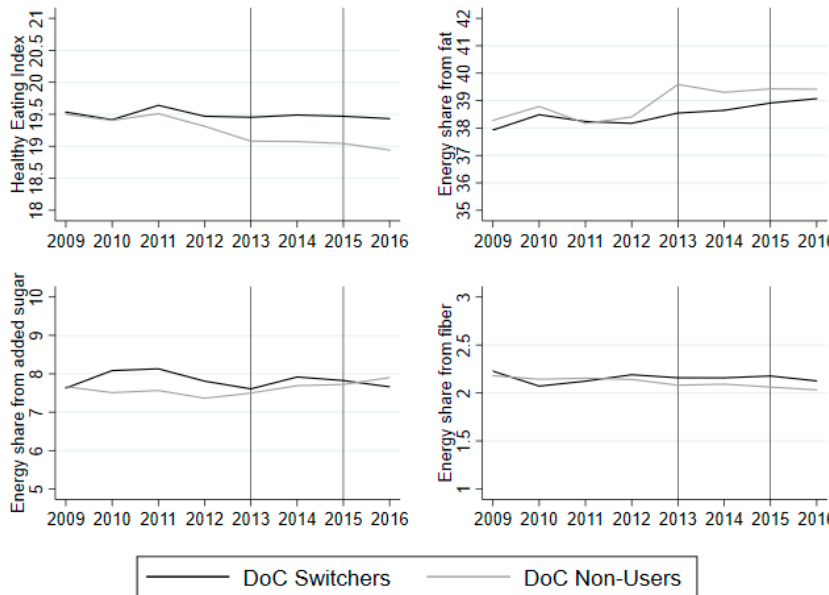
Figure 3. Average HEI and nutrient shares from 2009 to 2016 for DoC switchers (black) and non-users (grey). Note: The vertical lines indicate the years in which the questionnaires were sent to the panel. The average is based on households that answered the question on use of DoC in 2013 and 2015. The averages are based on an unbalanced panel from 2009 to 2016, as not all of the household stay in the panel from 2009 to